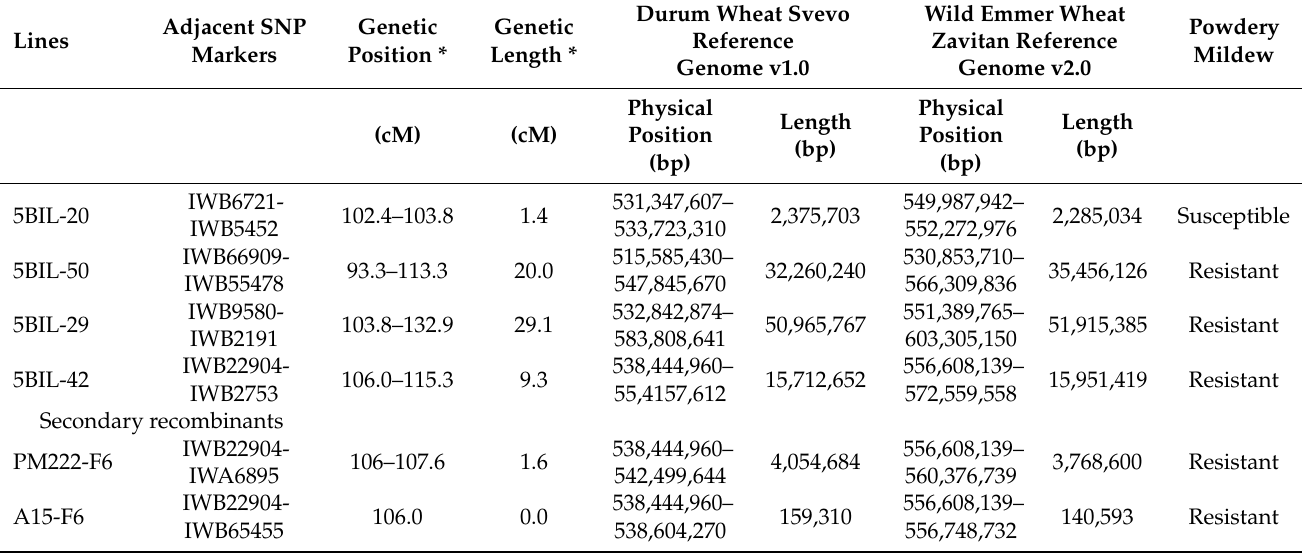
Table 1. Genetic and physical position in the durum wheat Svevo reference genome and in the wild emmer wheat Zavitan reference genome of the 5BL introgressed dicoccoides segments in six backcross inbred lines of durum